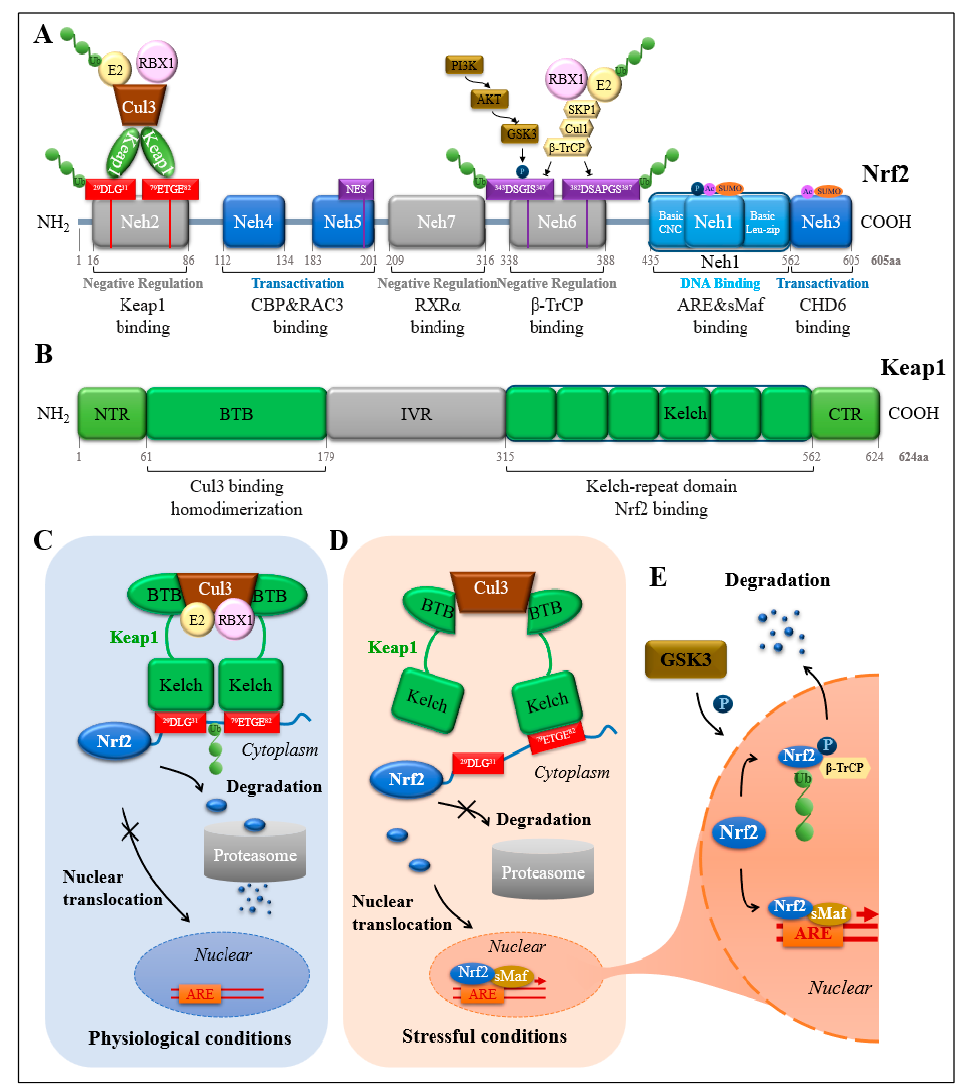
Figure 1. Detailed schematic diagram of Nrf2-related signaling pathway. Structural characteristics of Nrf2 ( A ) and Keap1 ( B ). The spatial patterns of interaction between Nrf2 and Keap1 under physiological conditions ( C ) and stressful conditions ( D ). The degradation of Nrf2 depends on different proteins under different conditions. Under physiological conditions, it depends on Keap1 ( C ); under stressful conditions, it depends on GSK-3 ( E ). Ub, ubiquitin; P, Phosphorylation; SUMO, small ubiquitin-like modifiers, SUMOylation; Ac,